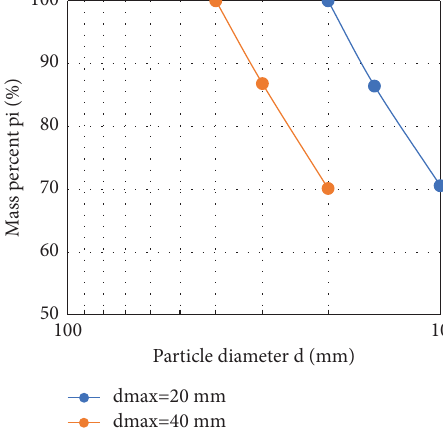
Figure 2: Gradation